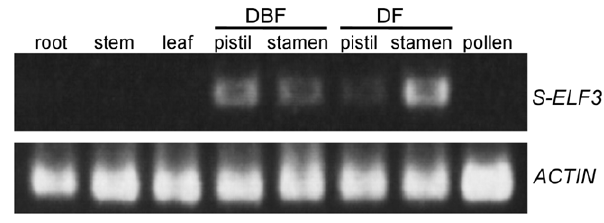
Figure 5. Expression analysis of S-ELF3 transcripts. cDNA prepared from roots, stems, leaves, pistils, stamens and pollen was used for RT-PCR analysis. ACTIN was amplified as a loading control. DBF: one day before flowering. DF: the day of